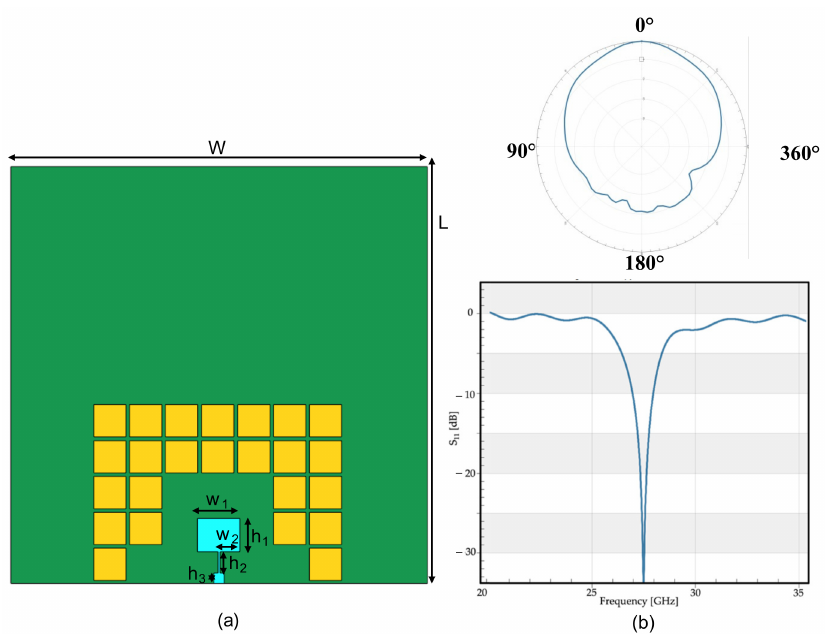
Figure 3. Second wearable patch antenna equipped with the simulated EBG: ( a ) geometry of the antenna, front view; ( b ) performances of the antenna in terms of, in the upper part, radiation pattern ( ϕ = 0 ◦ ) and, in the lower part, the reflection coefficient (S 11